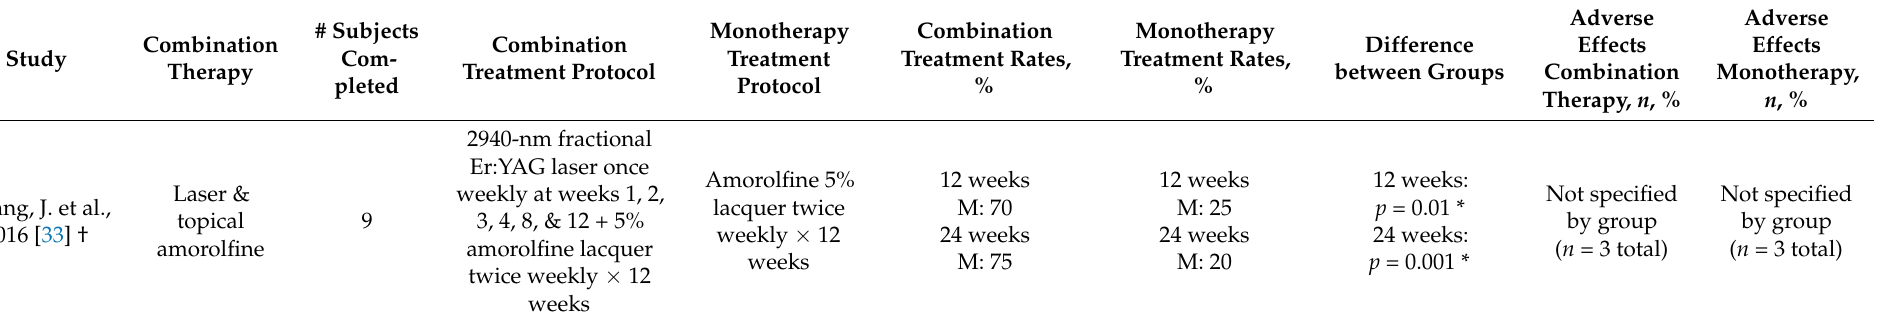
Table 2. Treatment protocols and outcomes for studies investigating procedures (debridement, photodynamic therapy, or lasers) in combination with medication for onychomycosis